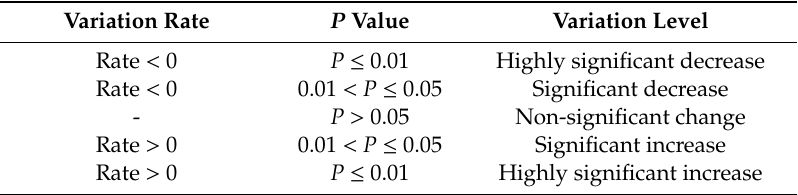
Table 3. Rules of variation trend